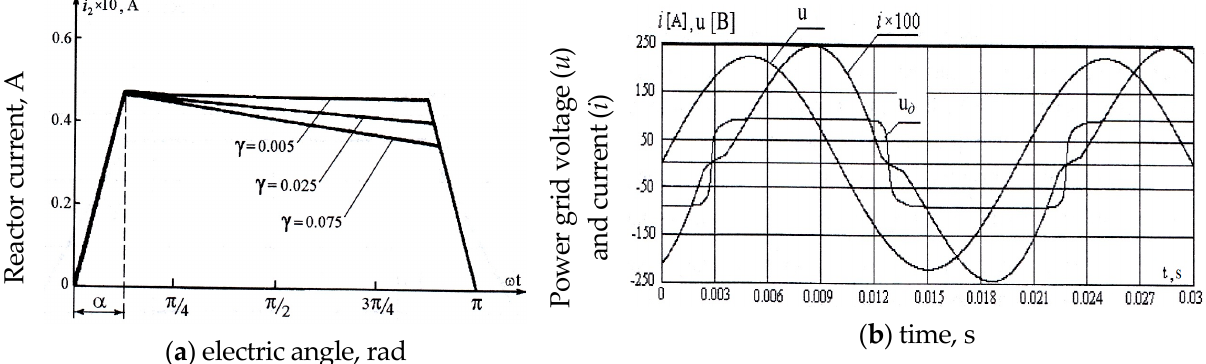
Figure 7. Analytically calculated choke current ( a ), mains voltage and network current ( b ) [31].